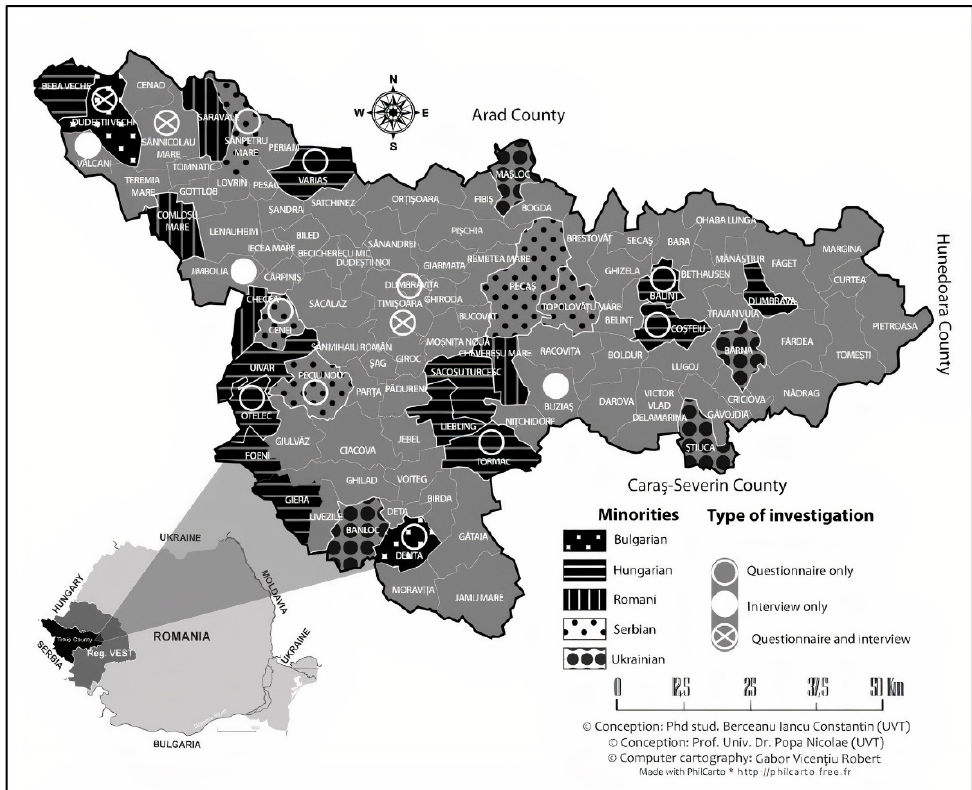
Figure 1. Timi ș County—Ethnic minority communities in which field research was conducted (the map shows only the administrative-territorial units in which ethnic minorities each have more than 20% of the total population in at least one locality, as well as cities with numerically significant minority communities).